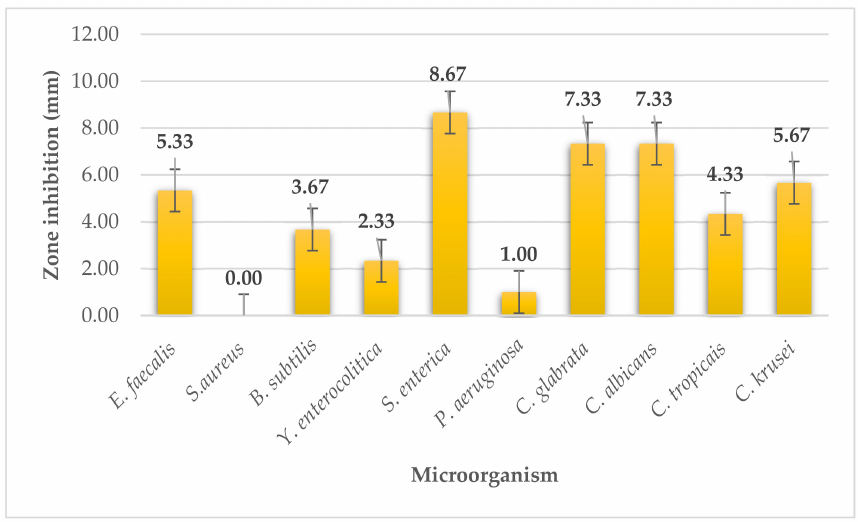
Figure 3. Antimicrobial activity of